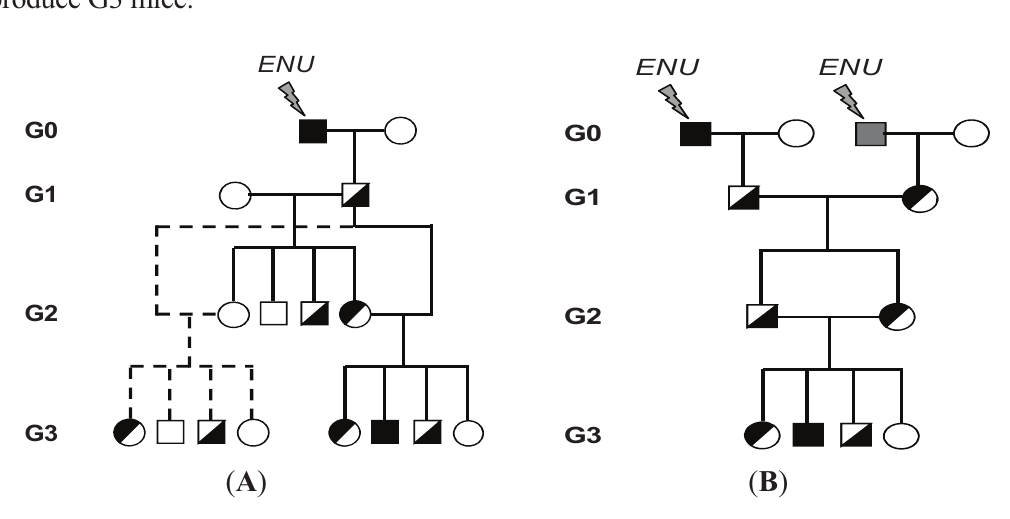
Figure 2. Breeding strategies used in our program to produce mice carrying homozygous N -ethyl- N -nitrosourea (ENU) mutations. ( A ) Treatment with ENU introduces mutations (indicated by a black or gray square) in the germ-line of males of generation 0 (G0). The mutagenized G0 male is out-crossed to a wild-type female to produce first generation (G1) animals. First generation G1 mice are carriers of ENU-induced mutations (indicated by half-filled black squares). G1 males are mated to wild-type females, to produce second generation (G2) animals, which carry about half of the mutation load present in the parental G1. Two G2 daughters are backcrossed to their G1 father to yield third-generation (G3) mice, where the original mutations have been brought to homozygosity (filled black squares). About 25% G3 progeny are expected to present a deviant phenotype in pedigrees that bear a given relevant recessive mutations; ( B ) In this strategy, the G1 progeny of two independent G0 males are intercrossed to produce G2 animals, which in turn are intercrossed to produce G3